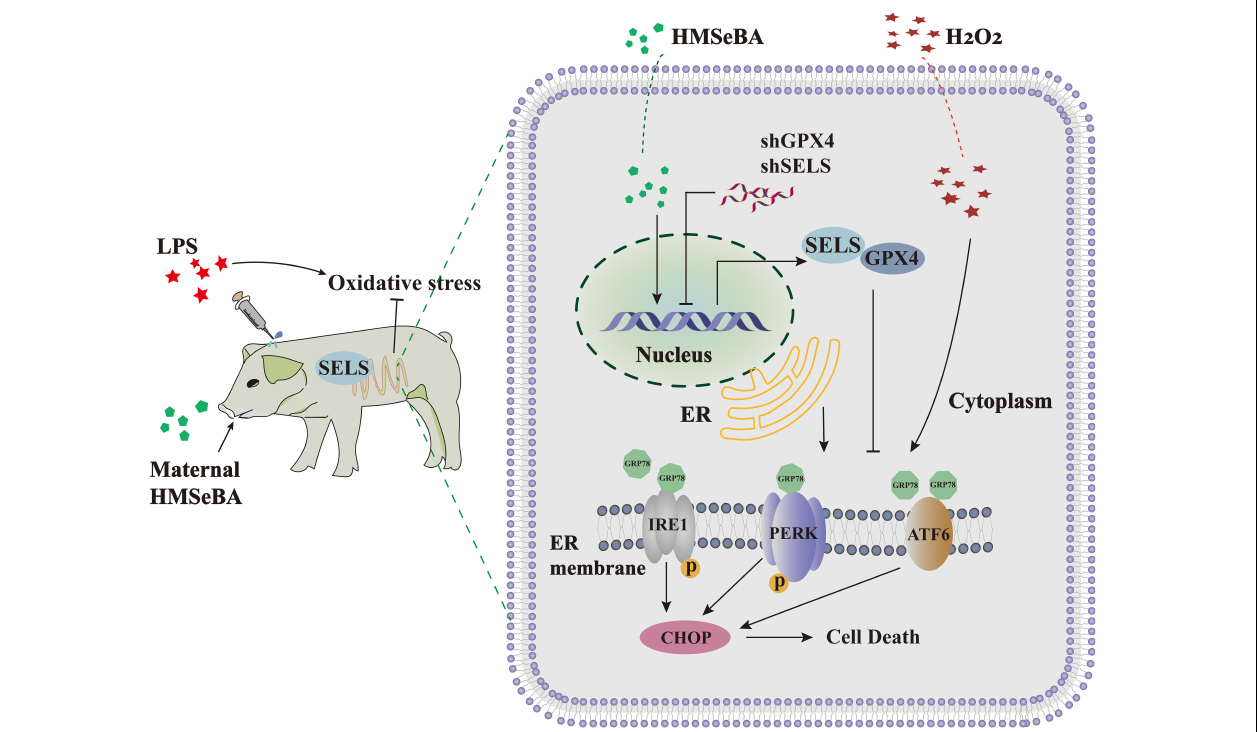
FIGURE 6 | General view of the effect of HMSeBA on intestinal ER stress. A model for HMSeBA supplementation regulates ER stress induced by LPS or H 2 O 2 in vivo and vitro . Only core components of the pathway are shown. LPS or H 2 O 2 administration induce ER stress through activating the GRP78-IRE1 α -CHOP signaling pathway. While HMSeBA treatment improves the expression of GPX4 and SELS, thereby suppresses the ER stress signal, ameliorates the redox status. Maternal HMSeBA is involved in regulating the ER stress signal and health of